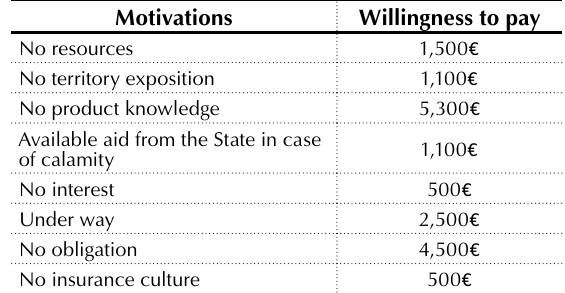
Table 4. Comparative analysis of motivations and willingness pay